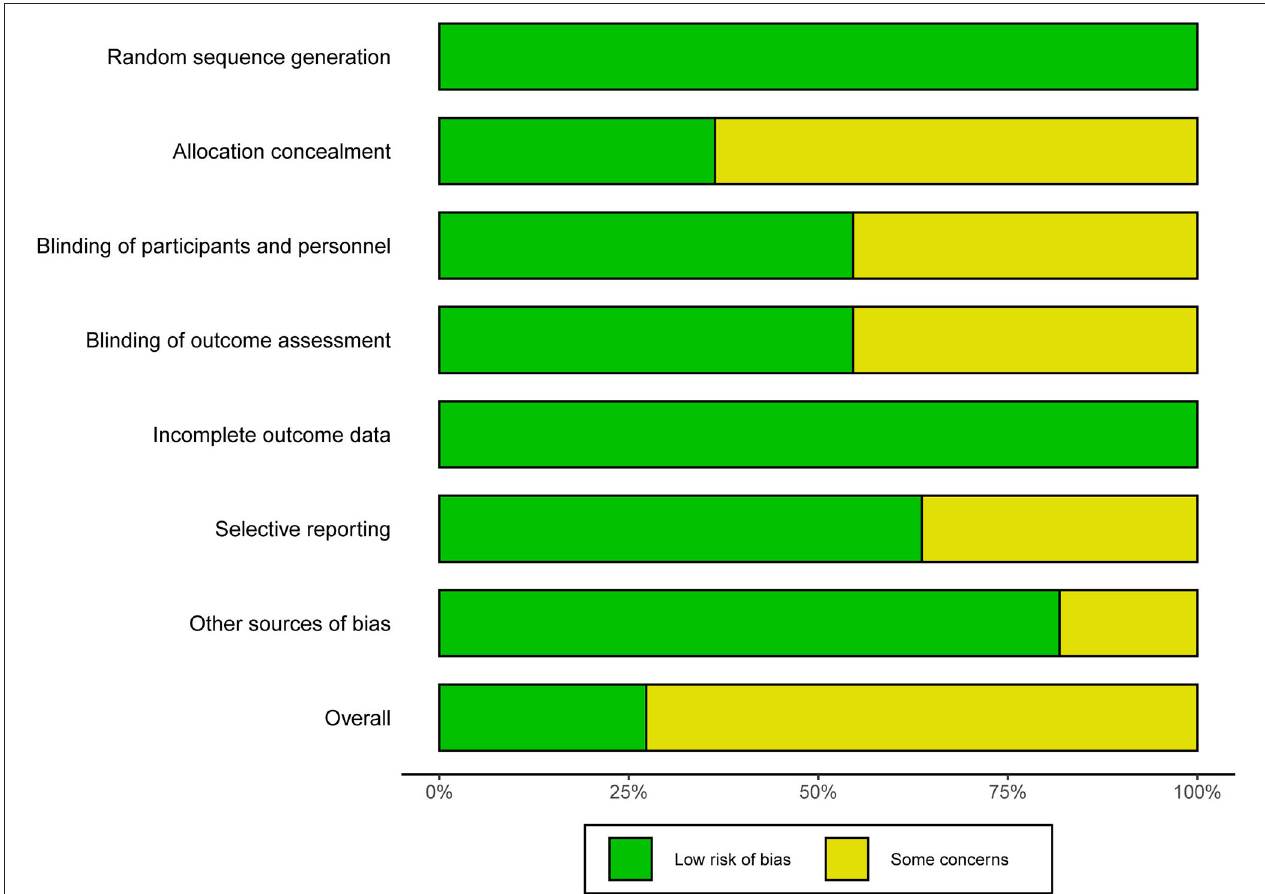
= − 9.49 ( − 11.83, − 7.14), P < 0.00001, fixed effects model] ( Supplementary Figure 2 ), the result didn’t substantially